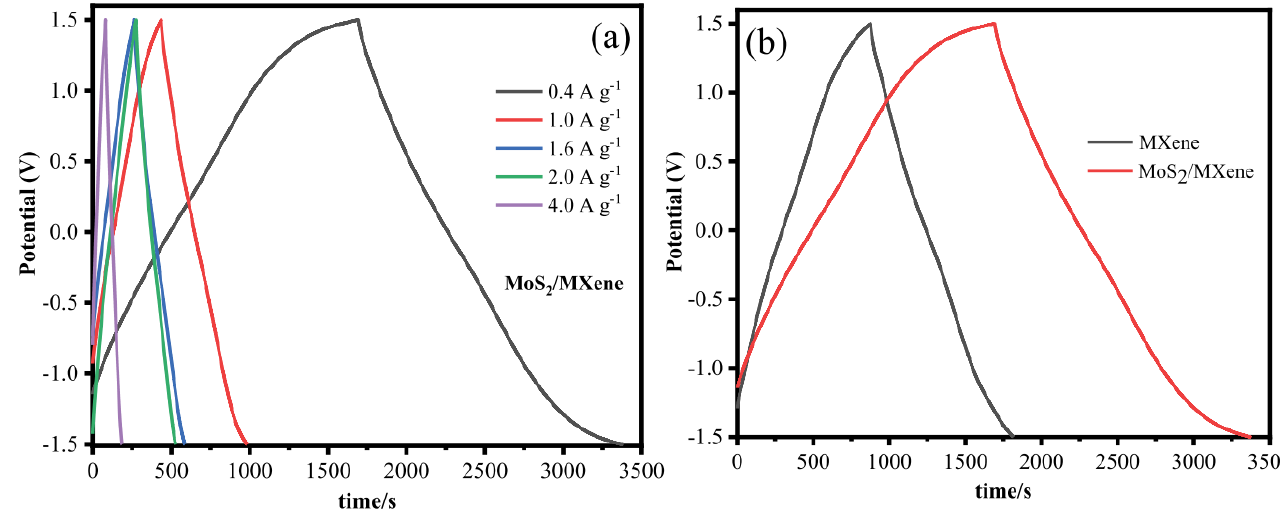
Figure 19. Galavostatic charge–discharge curve of MoS 2 /MXene from ref. [87]. ( a ) GCD curves of MXene/MoS 2 at at 0.4, 1.0, 1.6, 2.0, and 4.0 A g − 1 current densities, ( b ) GCD curves of MXene/MoS 2 and MXene at 0.4 A g − 1 current densities. Copyright 2020 Elsevier.